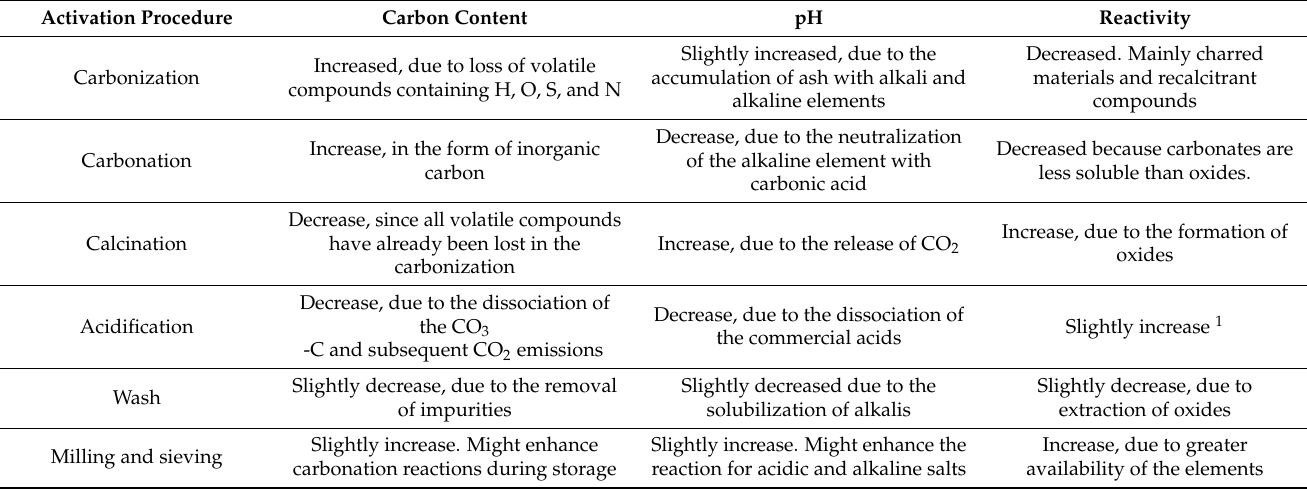
Table 3. Implications of the activation treatments that affect the suitability for a particular application (e.g., preparation of a slow-release fertilizer, liming agent, recovery of nutrients from wastewater, etc.). Elaborated by considering the information of